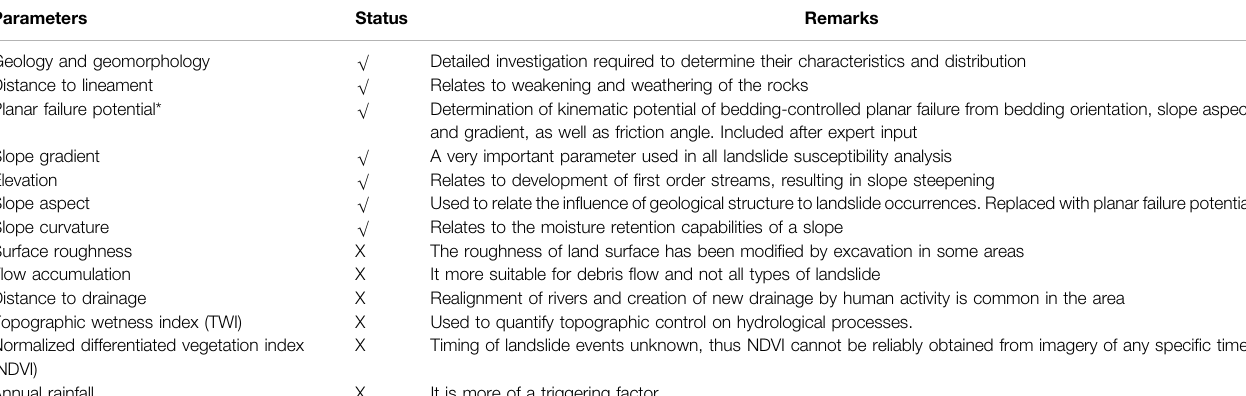
TABLE 1 | An overview of landslide-conditioning parameters used in the study. The expert consultation process resulted in 6 parameters being omitted and replacement of slope aspect with planar failure potential.